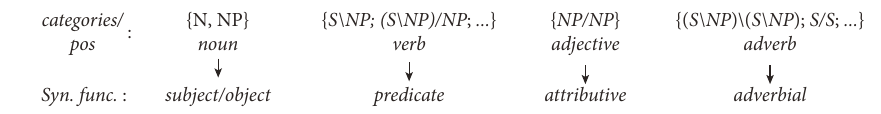
Figure 3: Mapping between categories/pos and syntactic functions.